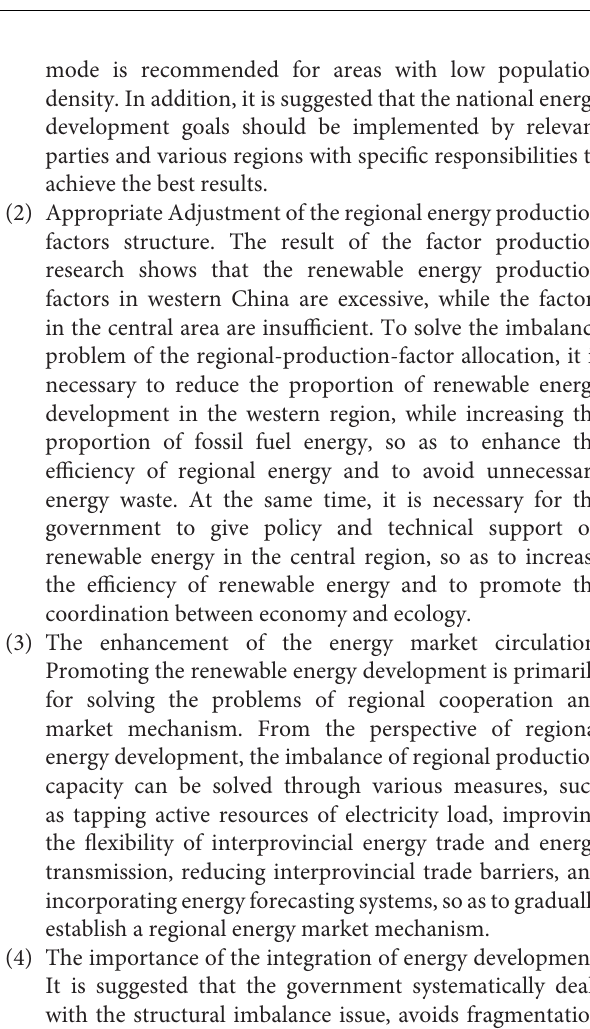
FIGURE 4 | Distribution diagram of China’s regional energy development